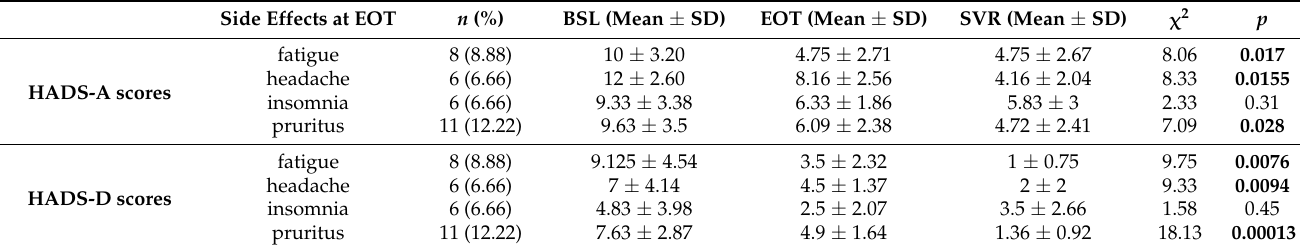
Table 7. Side-effects distribution according to the psychological status ( χ 2 Friedman test). On the p -Value column, bold is used in order to underline the statistically significant values of p